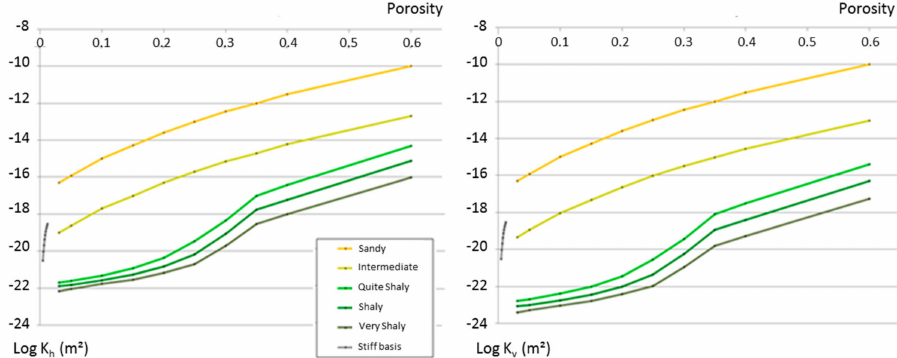
Figure A2. Horizontal and vertical permeability. For a given porosity, the shalier the facies, the less permeable the